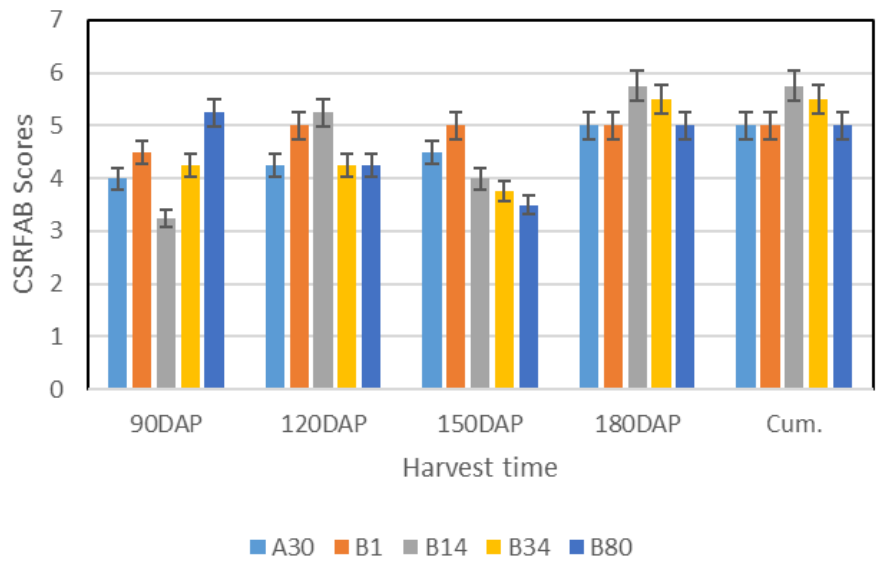
Figure 5. Growth pattern for continuous storage root formation and bulking (CSRFAB) of four sweetpotato genotypes representing different growth patterns over four harvest times (averaged across four environments). Note: DAP = days after planting; CSRFAB = Continuous storage root formation and bulking; Cum. = Cumulative scores. Scores show a trend which is similar across the four harvest times suggesting a possibility of predicting CSRFAB genotypes from early stages upwards. Genotypes A30, B1, B14 and B80 exhibit continuous bulking over the four harvest times. Cumulative scores were the same with 180DAP confirming the precision of the